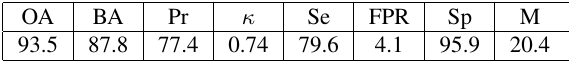
Table 1. Number of regions of interest (ROI) in summary, labeled as normal and as anomalous respectively, in the generated dataset and its subsets for training and testing.